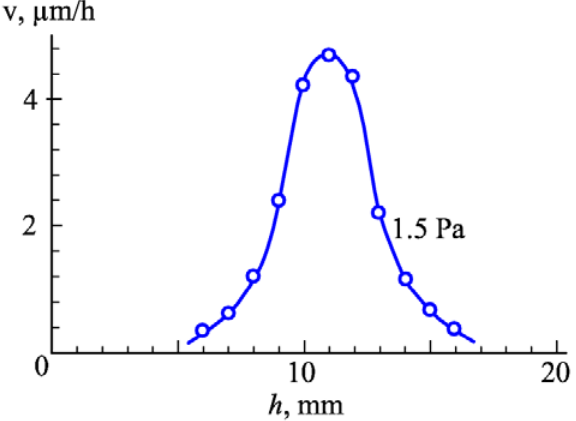
Fig. 5. The distribution of the target etching rate over